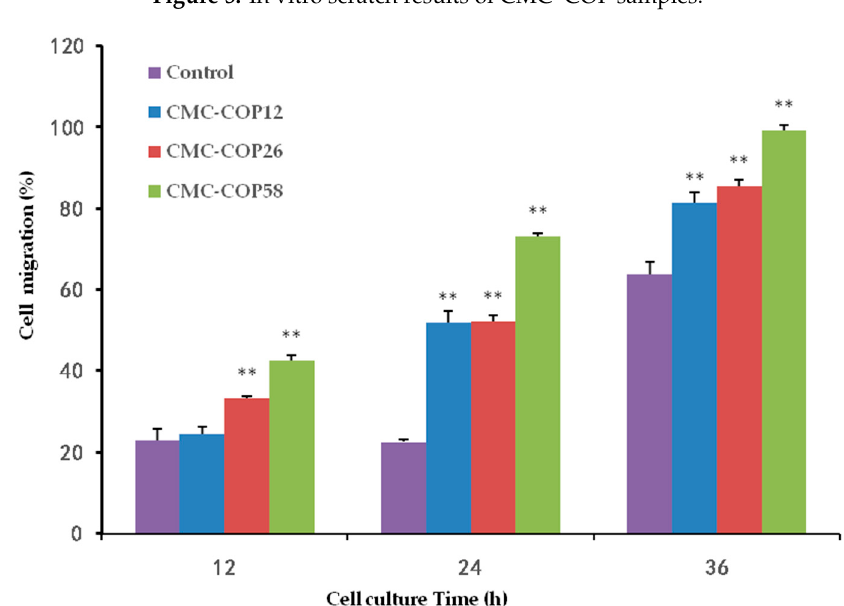
Figure 5. In vitro scratch results of CMC – COP samples.